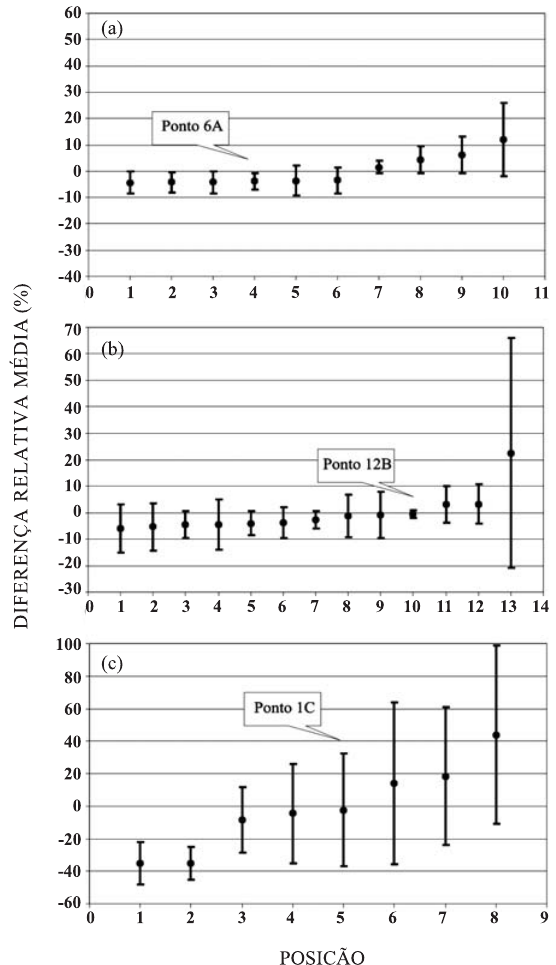
Figura 4. Diferença relativa média e respectivo desvio-padrão da umidade do solo durante o período de estiagem para as áreas de pastagem (A), Mata Atlântica (B) e vegetação de várzea (C), na bacia hidrográfica experimental do ribeirão Lavrinha, Serra da Mantiqueira,